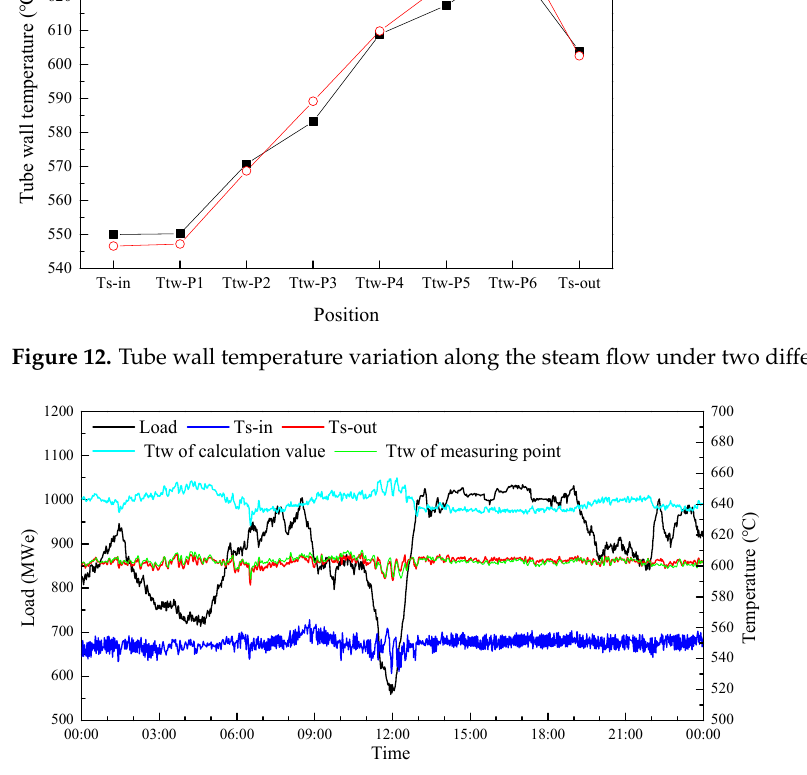
Figure 13. Tube wall temperature calculation results over 24 h.